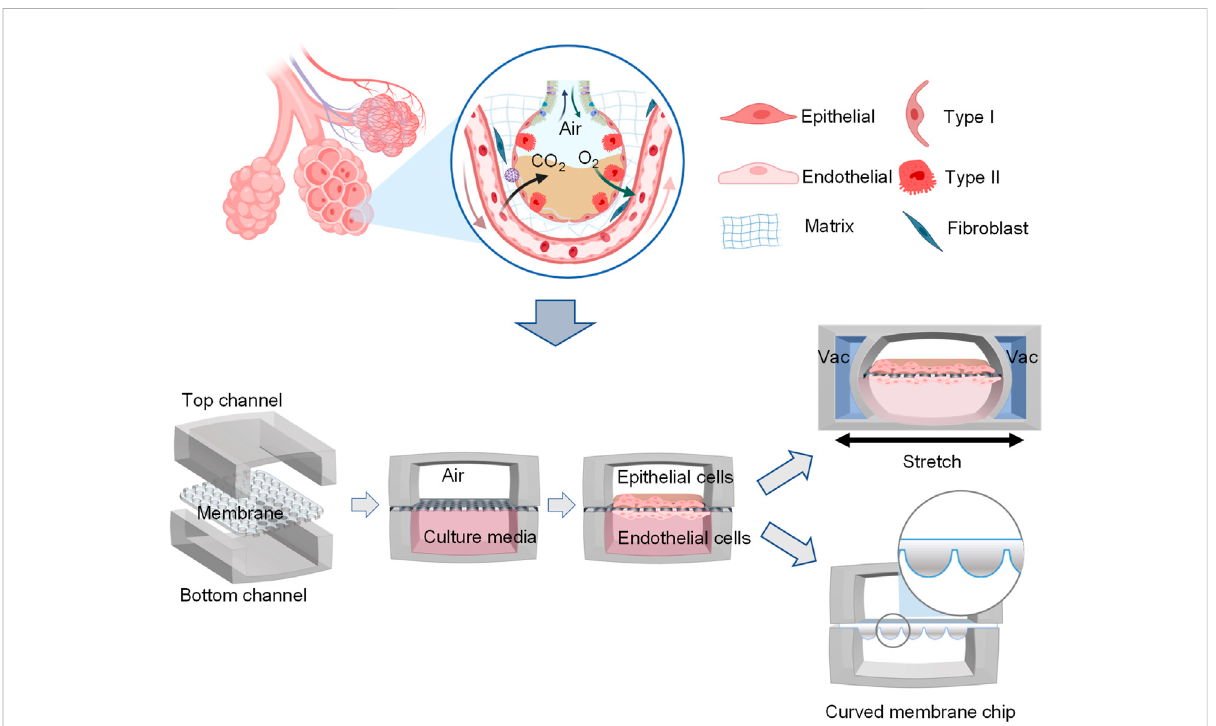
FIGURE 3 Schematic representation of functional lung-on-a-chip based on epithelium-endothelium interface physiology characteristic. During normal inspiration, pressure pulls air into the lungs, resulting in stretching of the alveolar epithelium. For mimicking this phenomenon, pressure-driven stretching by incorporating two larger, lateral microchambers into the device design (Huh et al., 2010). Also, microscale curved surfaces affect the spatiotemporal organization and behaviors of cells. The membrane was given the shape of hexagonally arrayed hemispherical microwells into the device design (Baptista et al.,